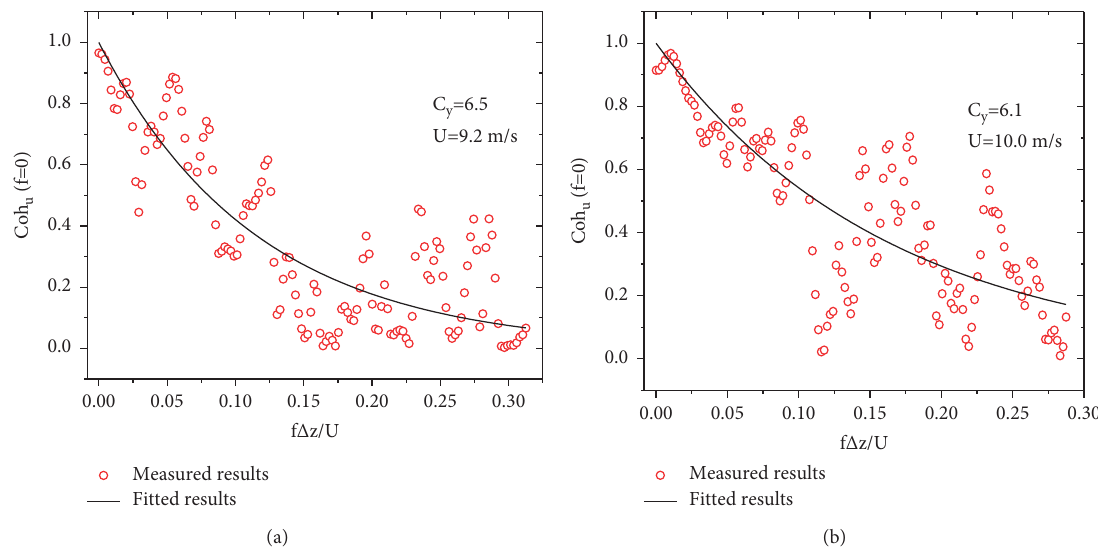
Figure 10: Coherence coefficient curves of the longitudinal fluctuating wind speed component in different wind speed periods.